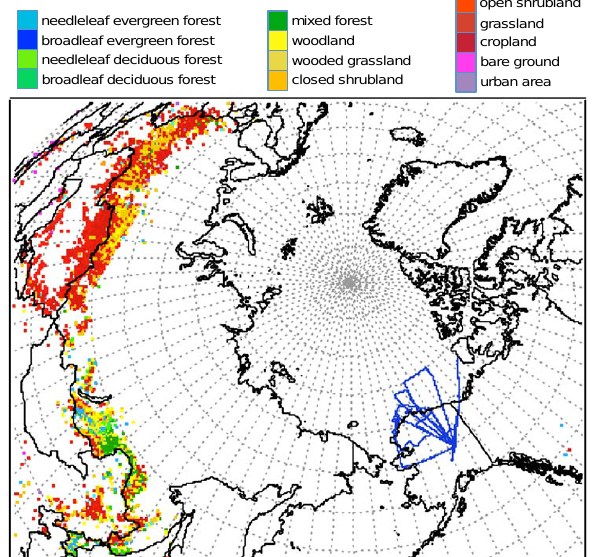
Fig. 9. Map showing fire locations for April 2008 determined from MODIS (NASA/University of Maryland, 2002), color-coded by the underlying vegetation type (Hansen et al.,